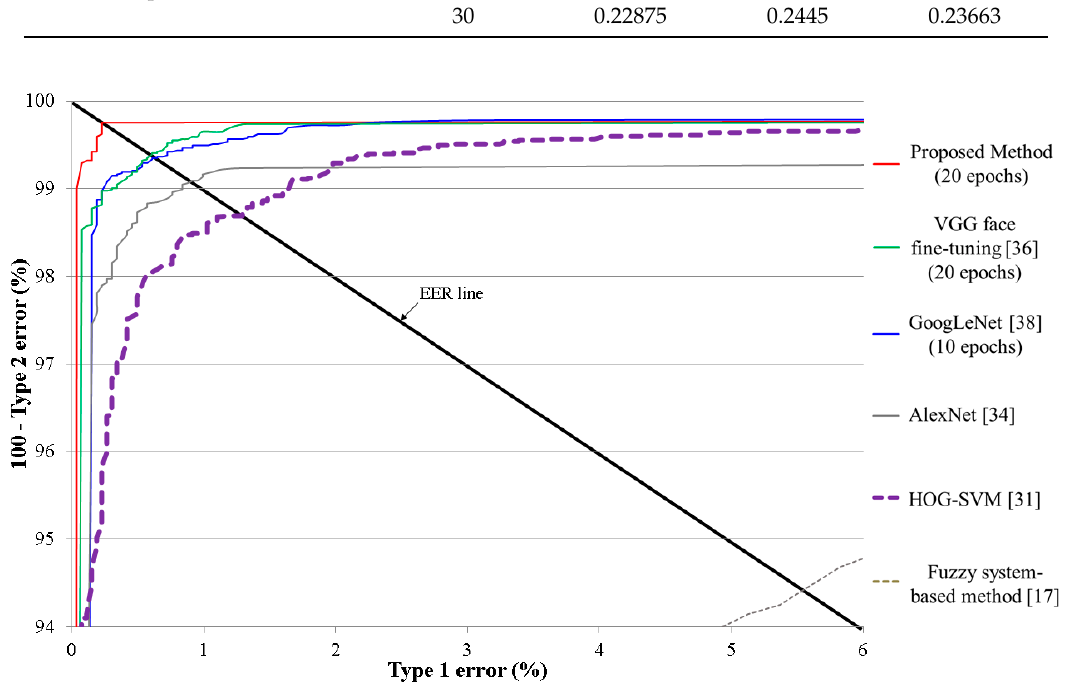
Figure 8. ROC curves for the testing data.